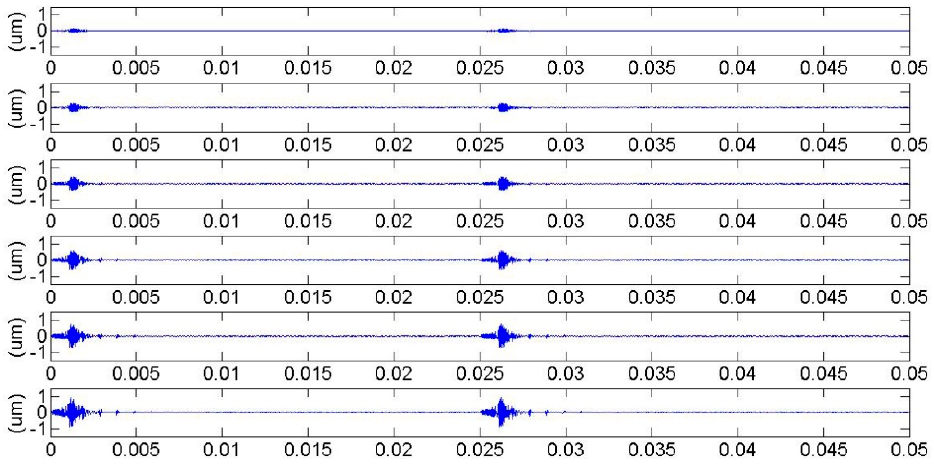
Figure 19. Vibration response for the cracked gear under the 1.5 mm modulus.